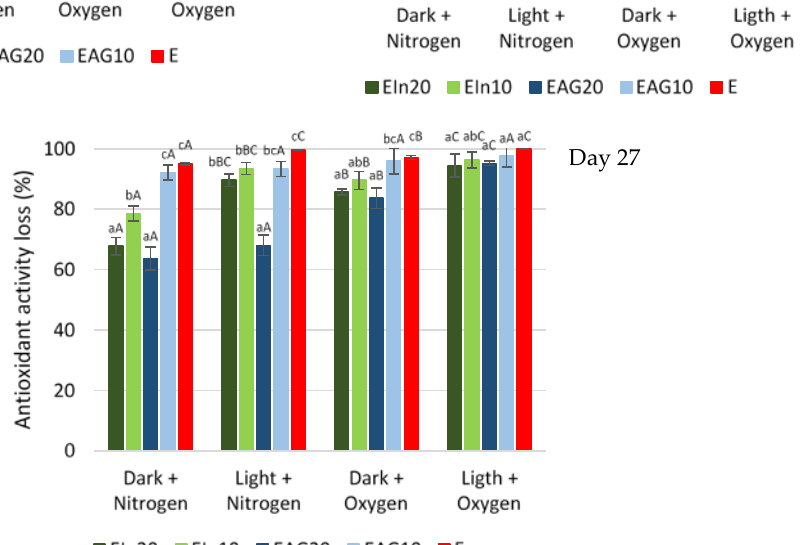
Figure 2. Antioxidant activity loss over the storage period under different conditions. Different letters represent statistically significant differences (Tukey test p < 0.05): uppercase letters (effect of environmental conditions on antioxidant activity loss); lowercase letters (effect of samples on antioxidant activity loss). EIn20–20% Inulin; EIn10–10% Inulin; EAG20–20% Arabic gum; EAG10–10% Arabic gum; E-tomato pomace extract.